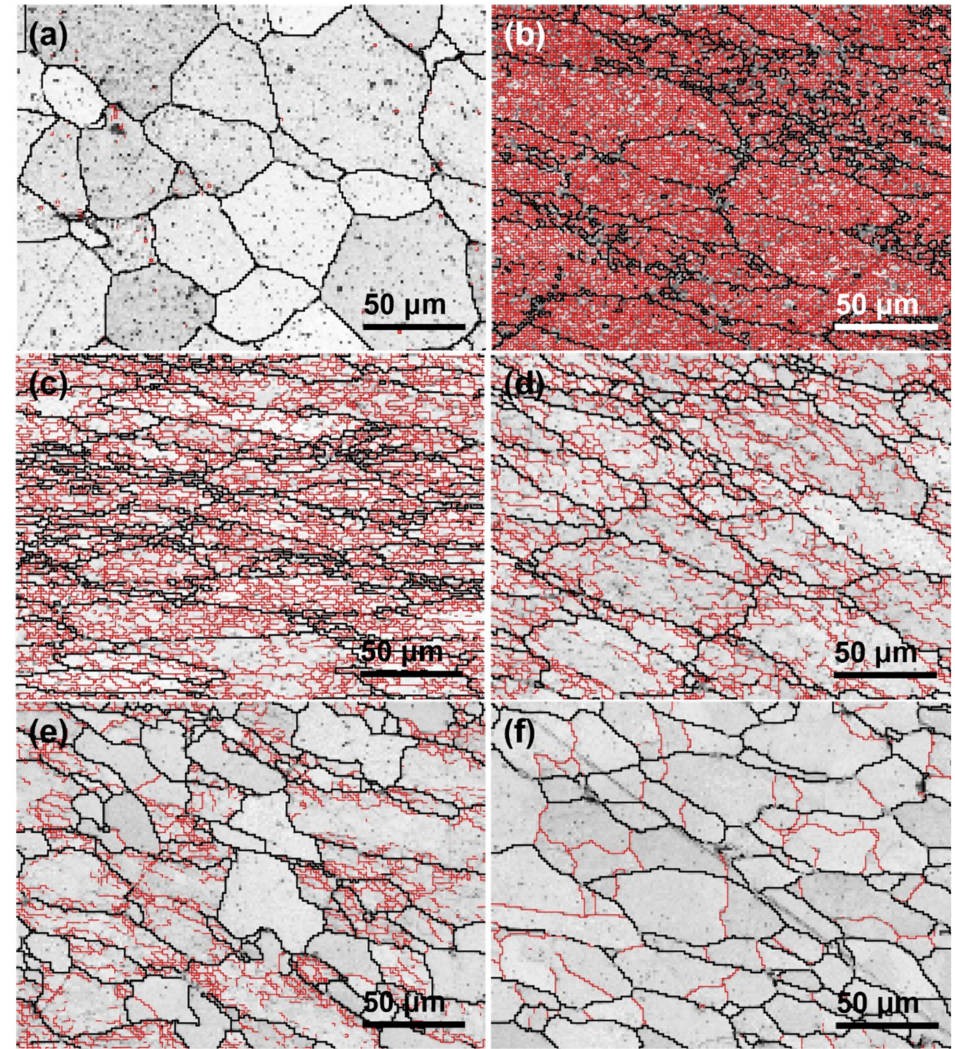
Figure 5. EBSD images of grain morphology of spray-deposited 7055 aluminum alloy ( a ) and under hot compression conditions of 300 ◦ C/5 s − 1 ( b ), 300 ◦ C/0.001 s − 1 ( c ), 400 ◦ C/0.1 s − 1 ( d ), 450 ◦ C/5 s − 1 ( e ) and 450 ◦ C/0.001 s − 1 ( f ) (Black line represents the high angle grain boundaries (HAGBs) which are higher than 15 ◦ , and the red line represents the low angle grain boundaries (LAGBs) ranging from 2 ◦ to 15 ◦